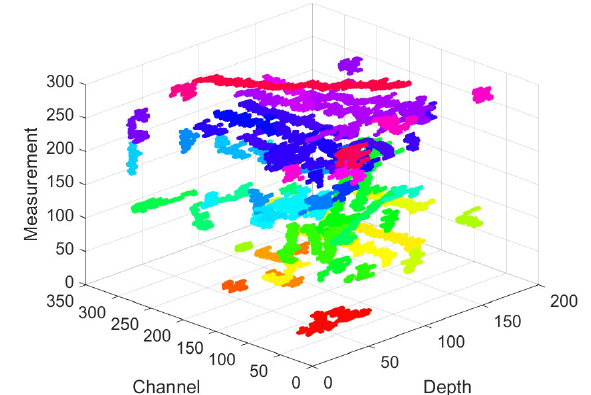
Figure 12 . 3D data cube as result of the fusion of both processing directions.